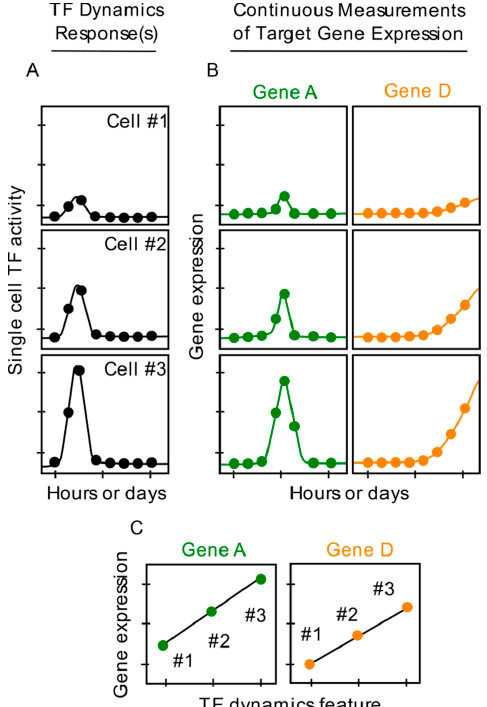
Figure 3. Use of fluorescent reporter proteins enables continuous measurements of TF dynamics and gene expression in the same single cells. ( A ). Single cell TF dynamic responses imaged continuously (dots) after hypothetical cell activation. ( B ). Continuous measurements (dots) of single cell gene expression levels for hypothetical genes A and D. ( C ). Graphs depicting correlation, due to sufficient data, between TF dynamics ( A ) and single cell expression levels of genes A and D ( B ). Positive correlation between TF dynamics and hypothetical genes B and C are not shown.